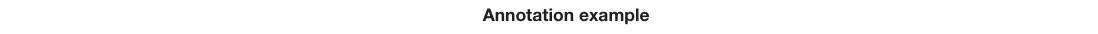
TABLE 4 | Event element annotation.